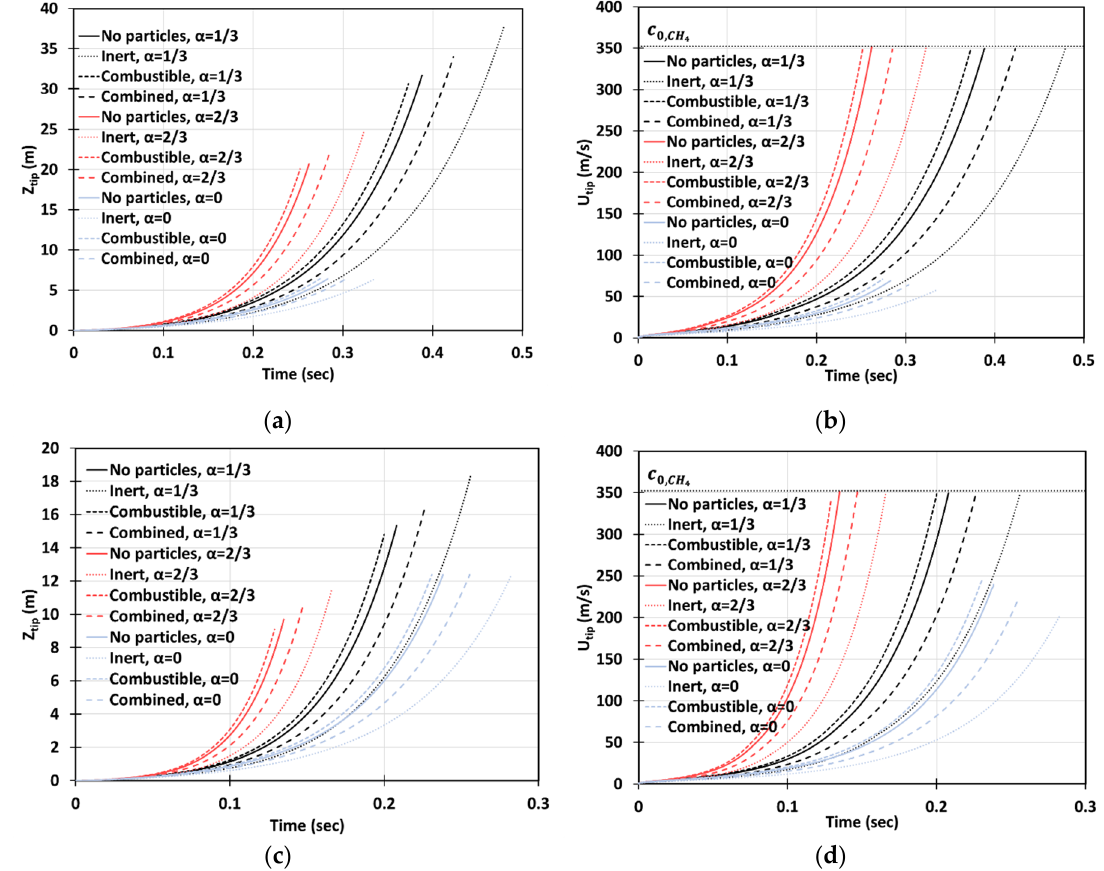
Figure 13. Time evolution of the flame tip position Z tip ( a , c ) and velocity U tip ( b , d ) in a 2D ( a , b ) and cylindrical-axisymmetric ( c , d ) geometries for lean CH 4 -air burning of φ = 0.7, without and with dust particles (combustible, inert, and combined) of particle radius r s = 75 µ m and concentration c s = 50 g/m 3 , for various blockage ratios, α =